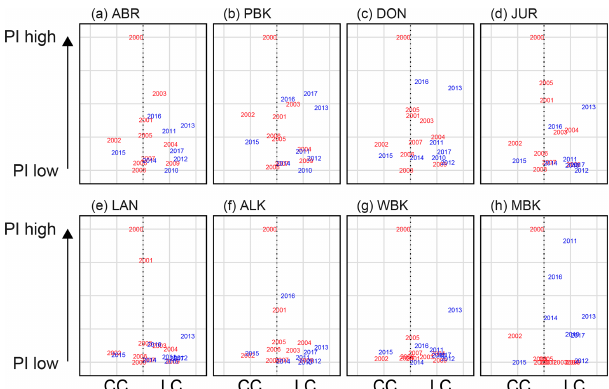
Figure 13. Relationship of the more dominant current during the early spring–early summer (September–November) to early PI at monitoring sites (a) Abrolhos, (b) Port Gregory, (c) Dongara, (d) Jurien Bay, (e) Lancelin, (f) Alkimos, (g) Warnbro, and (h) Cape Mentelle. The x axis is the difference between the LC and CC stan- dardized, providing an indication of which is more prominent at the time. Red indicates the seasons before the recruitment failure, and blue indicates seasons